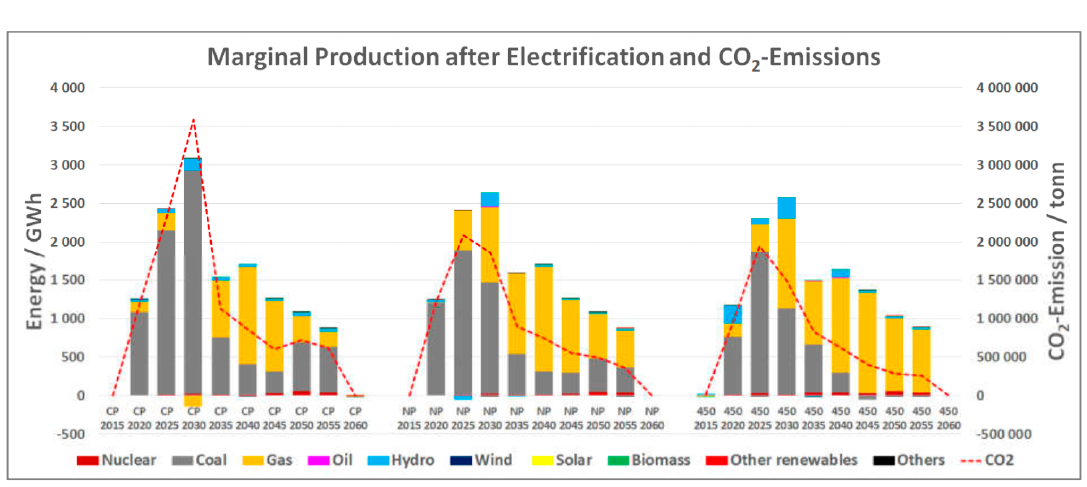
Figure 10. Comparison of the marginal generation of all results after the electrification.